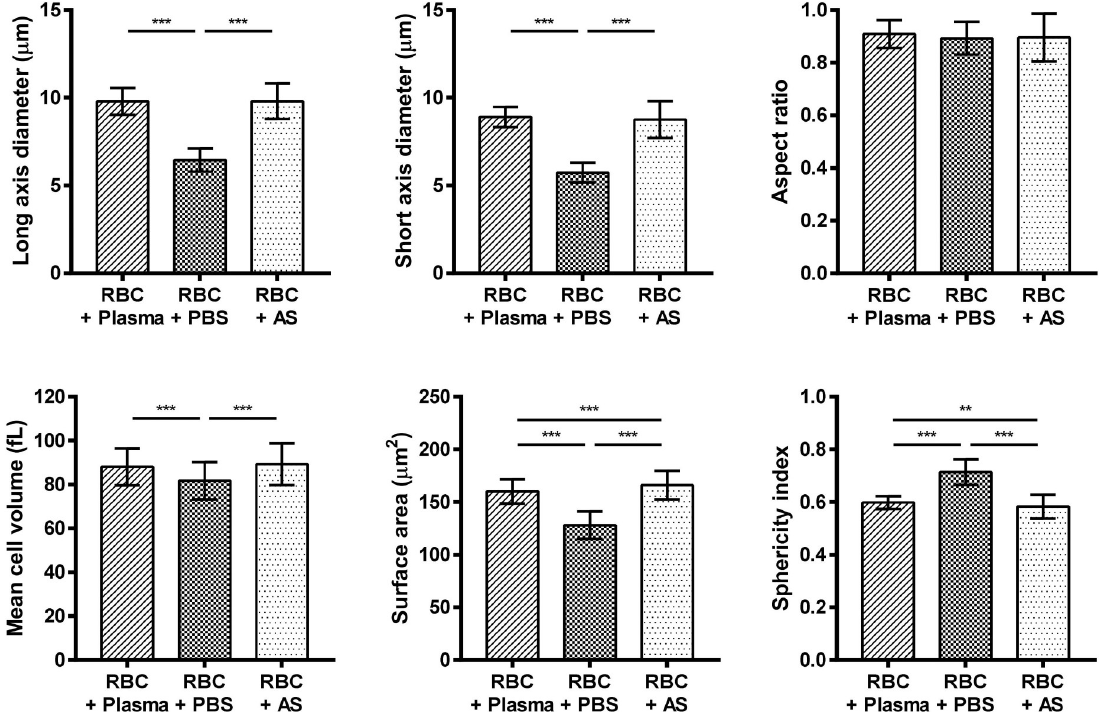
Fig 2. Comparison of the morphological parameters of RBCs in the conventional solutions. Asterisks correspond to the following p- values: � p < 0.05, �� p < 0.01, ��� p < 0.001. RBC, red blood cell; PBS, phosphate-buffered saline; AS, Alsever’s solution.